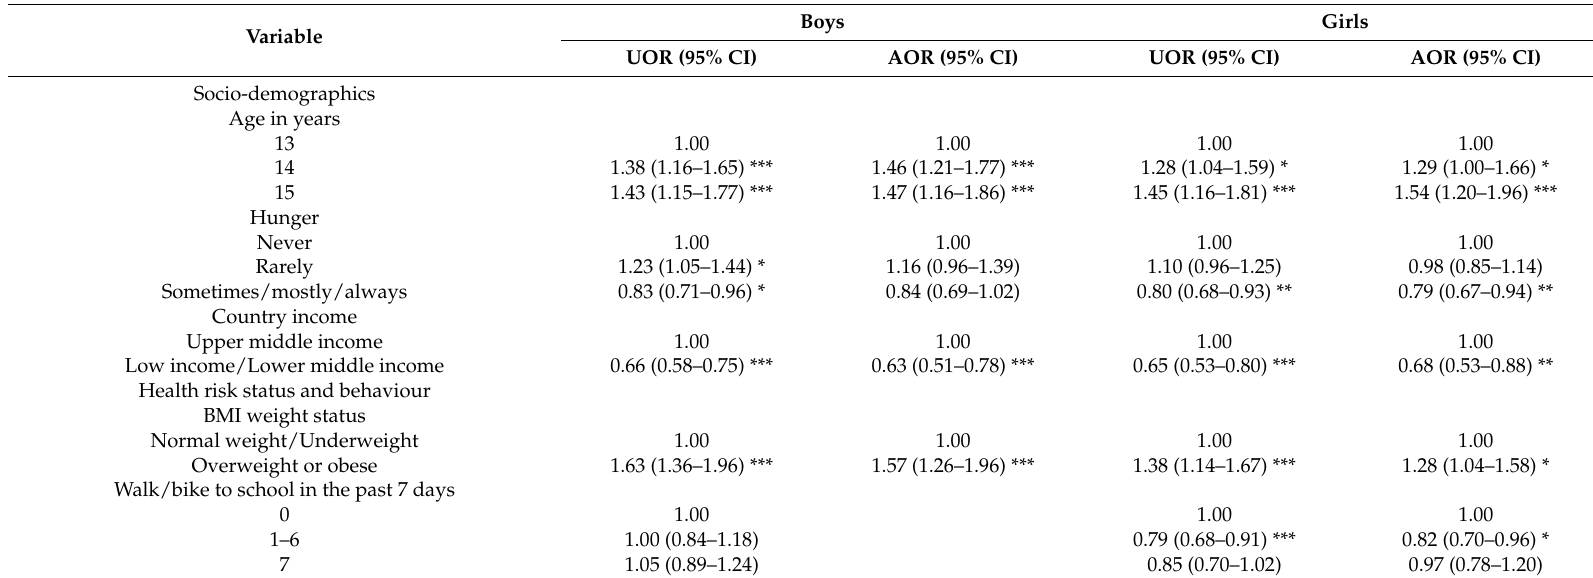
Table 6. Associations between sedentary behaviour prevalence, health behaviour, mental health and protective factor variables in school going adolescents by gender from 7 ASEAN